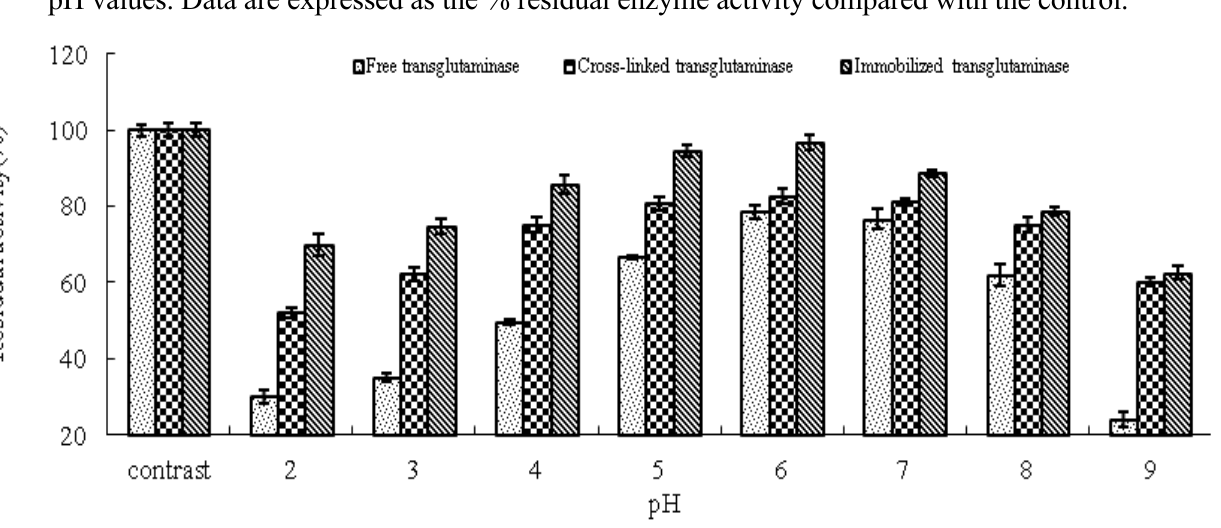
Figure 5. pH stabilities of free, cross-linked and immobilized transglutaminase at different pH values. Data are expressed as the % residual enzyme activity compared with the